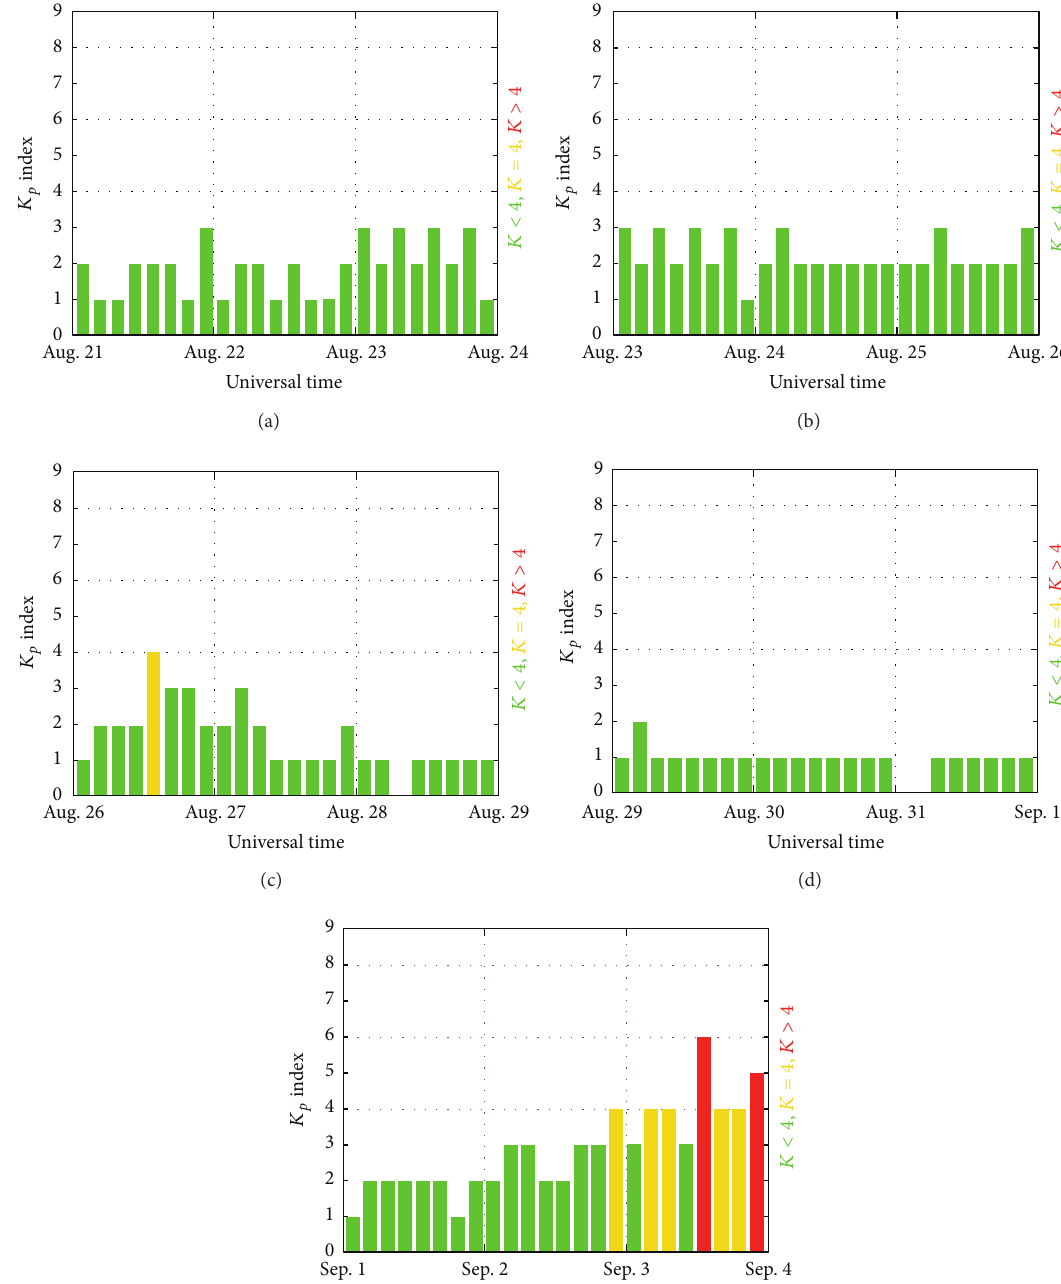
Figure 3: The figures show the 𝐾 𝑝 indices from 21 August to 03 Septembers 2012 (UT) (NOAA Space Weather Prediction Center).